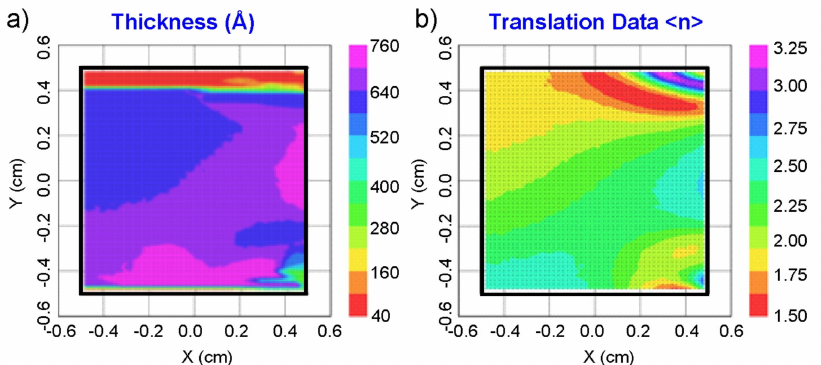
Figure 9. Homogeneity maps of S75 WO 3 film: thickness ( a ), and refractive index for λ = 632 nm ( b